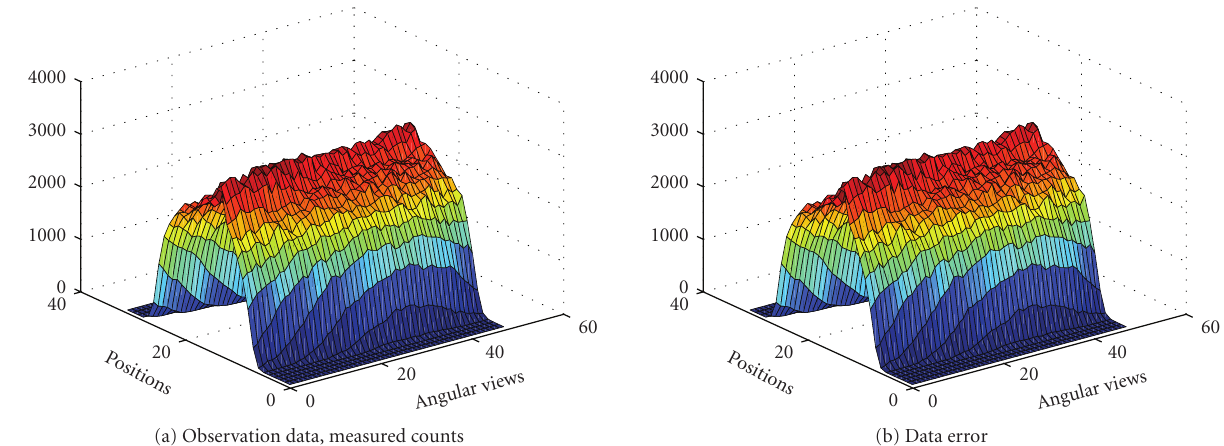
Figure 2: Sinogram data, obtained by forward projection: n = Pλ plus Poisson